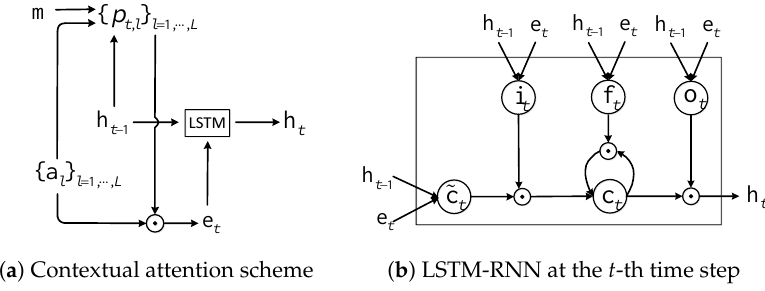
Figure 2. Illustrations of contextual attention scheme and LSTM-RNN at the t -th time